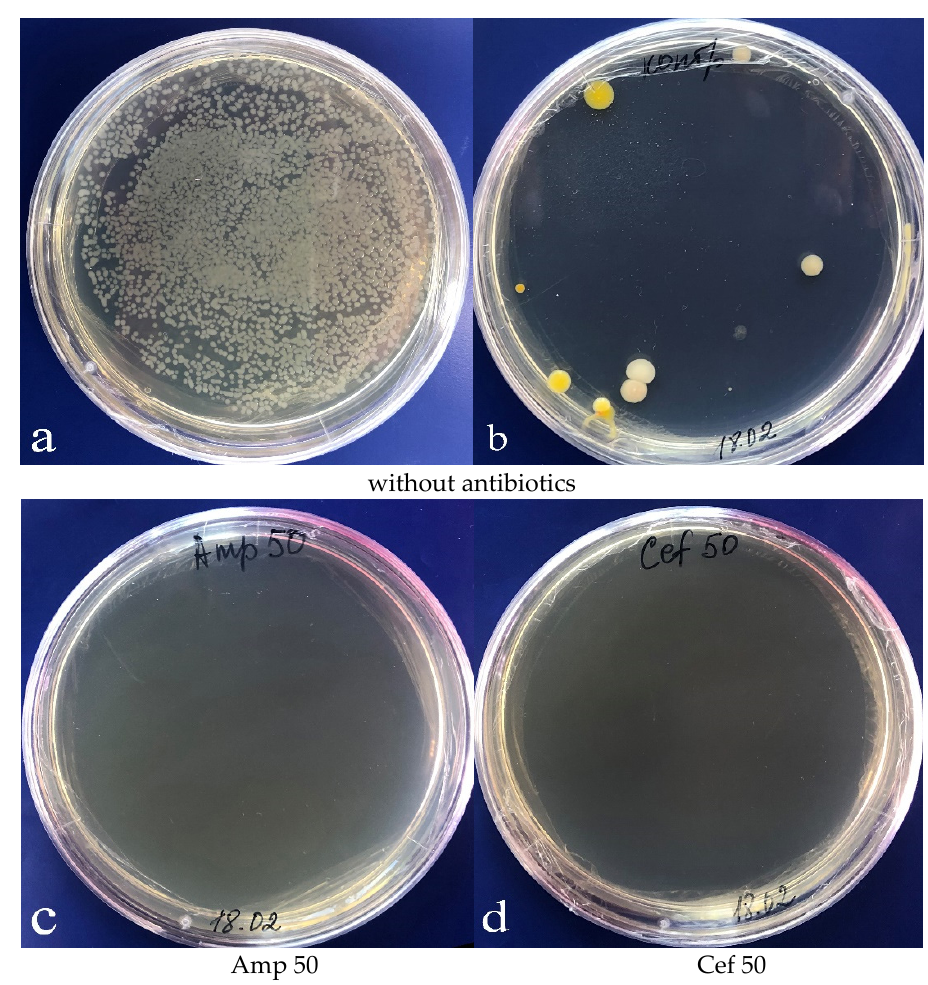
Figure 4. Determination of the sensitivity of contaminating bacteria in microspore culture to antibiotics on LB medium: ( a ) control development of bacteria colony with similar phenotype on LB medium without antibiotics; ( b ) control development of phenotypic diversity bacteria colony on medium without antibiotics; ( c ) inhibition of the bacteria growth on LB medium with ampicillin 50 mg/L; ( d ) inhibition of the bacteria growth on LB medium with cefotaxime 50 mg/L. To determine the efficacy of antibiotics in a culture medium, we compared how antibiotic type and concentration affected the mean B. napus embryo yield (Figure 5).